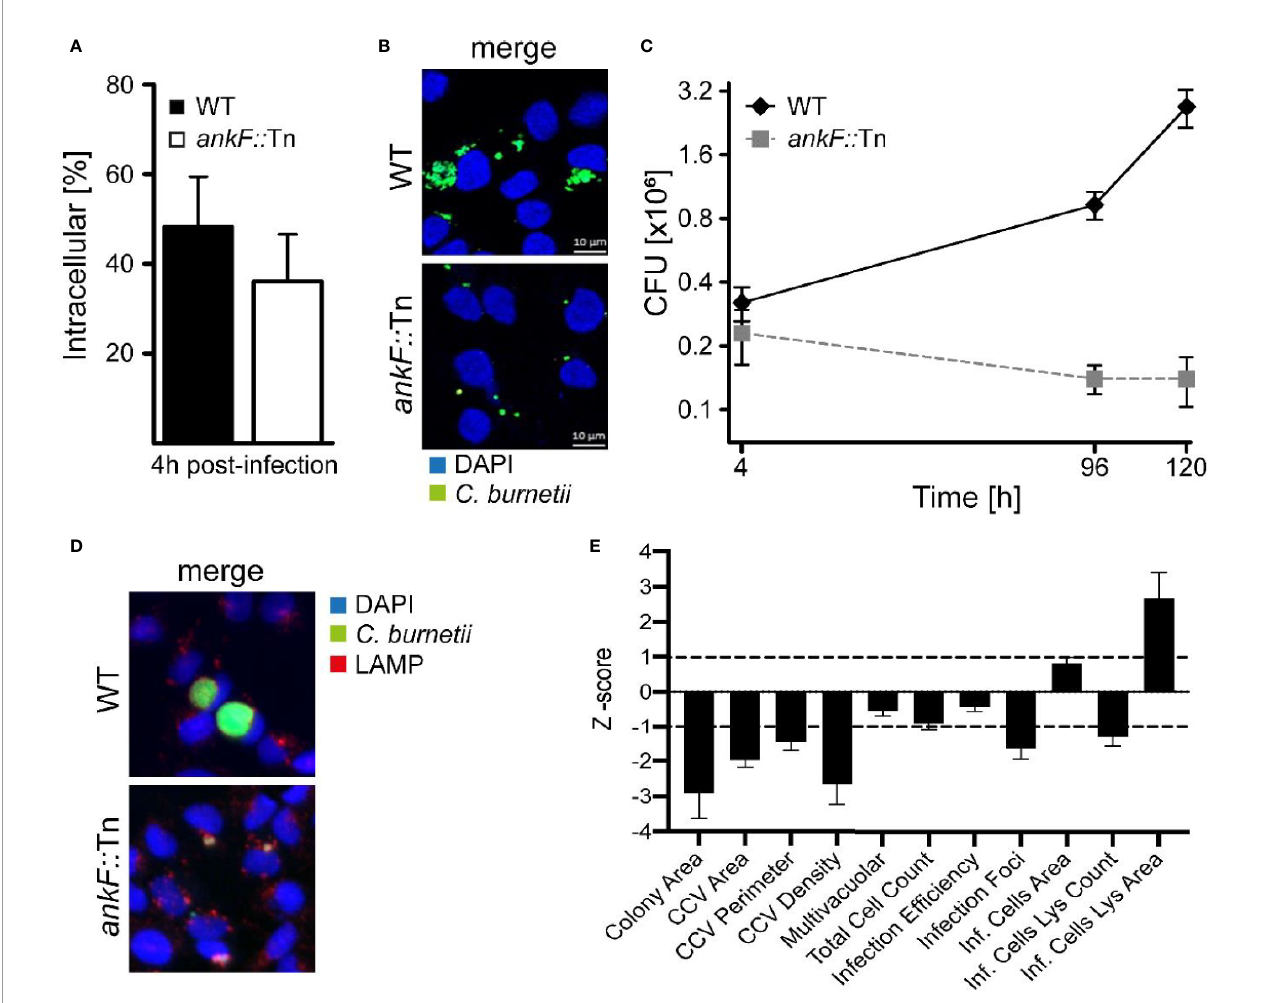
FIGURE 3 | The C. burnetii T4SS effector AnkF is essential for intracellular replication. (A, B) HeLa cells were infected with wild-type C. burnetii (WT) and ankF ::Tn ( ankF ::Tn) at an MOI of 50. (A) 4 h post-infection the number of intracellular bacteria was determined from 100 infected cells. Error bars represent mean standard deviations of three independent experiments. (B) 48 h post-infection, the cells were fi xed and stained with antisera against C. burnetii (green). Nuclei and bacterial DNA were stained with DAPI (blue). Representative LSM images are shown. (C) Human monocyte-derived macrophages were infected with wild-type C. burnetii (WT) and ankF ::Tn ( ankF ::Tn) at an MOI of 10 for 4, 96, and 120 h. The bacterial numbers were determined by colony-forming unit (CFU) counts. Error bars represent the mean standard deviation of three independent experiments. (D, E) U2OS cells were challenged either with wild-type C. burnetii or the ankF ::Tn mutant strain, both expressing GFP, at an MOI of 100. Six days post-infection, cells were fi xed and labeled with an anti-LAMP1 antibody (red) and Hoechst (blue) to visualize CCVs and host cell nuclei, respectively. (D) Images were acquired with an Arrayscan VTI Live epi fl uorescence automated microscope equipped with a 20× objective and an ORCA ER CCD camera. Representative images are shown. (E) An average of 50,000 cells were then automatically imaged and analyzed from triplicate experiments for each condition and the phenotypic pro fi le of the ankF ::Tn mutant was compared to that of wild-type C. burnetii and expressed as z-scores over 11 independent